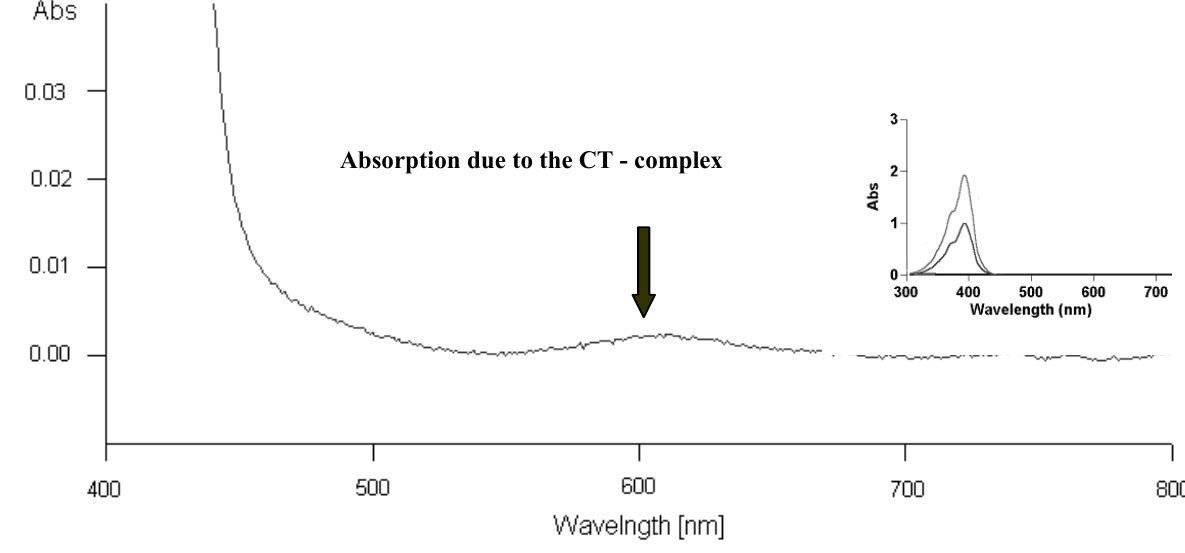
Figure 7. Absorption spectrum of the 3 –TCNQ complex in a LB film (3 layers) [37], absorption spectrum of TCNQ as an inset.